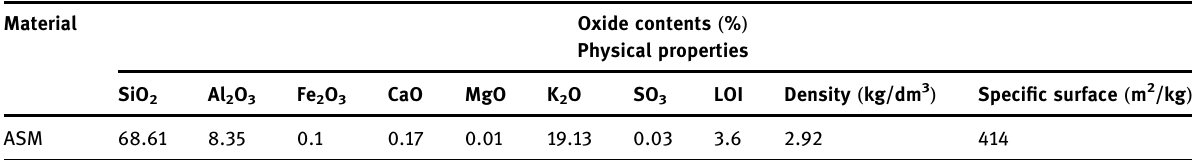
Table 5: Chemical composition of ASM of Burshtynskaya TPP